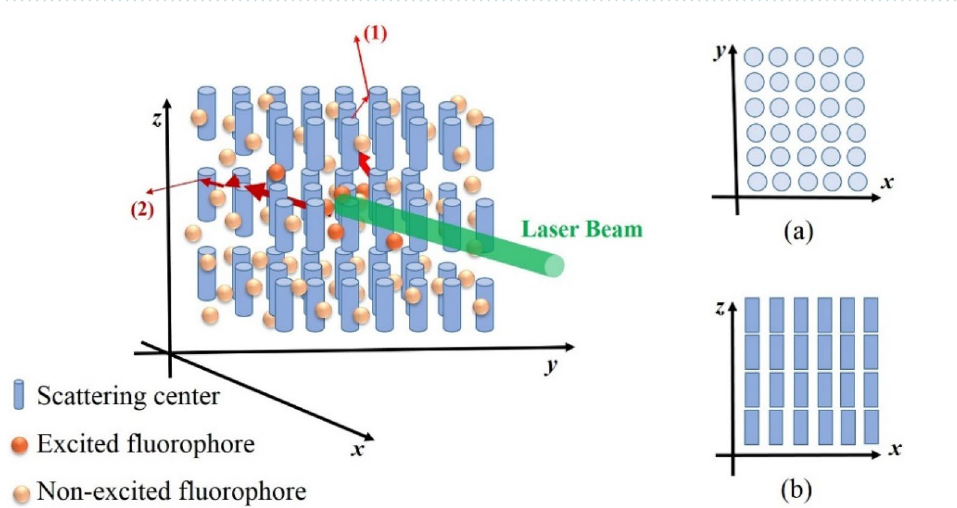
Figure 2. Typical model of the optically anisotropic medium that contains cylindrical-shape particles orderly dispersed in a homogeneous dye solution. The medium is locally pumped by a narrow laser beam along x-direction. Two pathways (1) and (2) show typical fluorescence photons emitted in the z and y directions, respectively. Inset ( a ) and ( b ) indicate the cross sections of the medium that photons (1) and (2) encounter